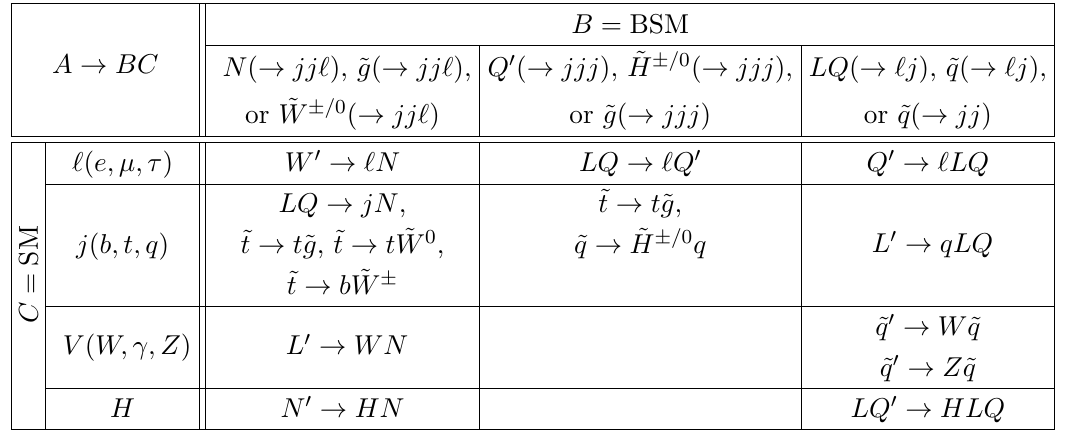
Table 4 . Example (Group IV in table 1) for A ! BC , where A and B are BSM particles and C is a SM particle. The B decays to more complex (cid:12)nal states are considered. The L 0 is a vector-like lepton, and N denotes a right-handed heavy neutrino which can decay to N ! W 0 ( (cid:3) ) ‘ ! jj‘ . The Q 0 represents a generic vector-like quark decaying to Q 0 ! W 0 ( (cid:3) ) j ! jjj . The ~ t denotes a stop, and the ~ g is a gluino which decays through RPV couplings [31, 32]. The ~ W 0 and ~ W (cid:6) are neutral and charged winos respectively. The neutral and charged Higgsinos, ~ H 0 and ~ H (cid:6) , can decay to ~ H (cid:6) = 0 ! j ~ q (cid:3) ! jjj through RPV